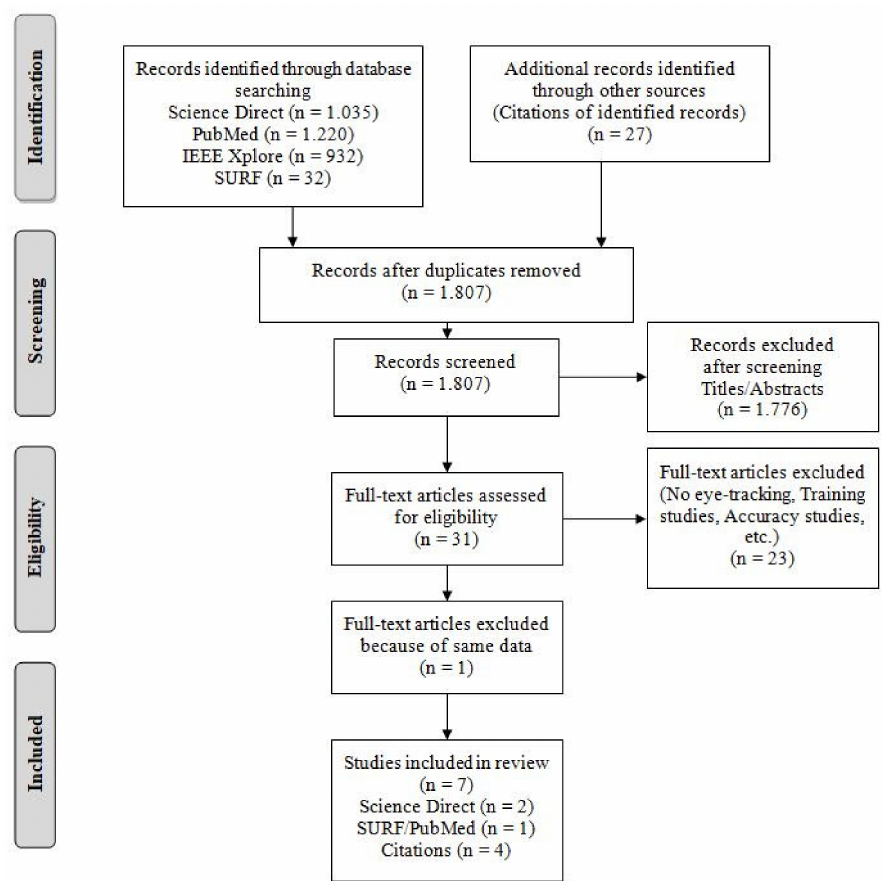
Figure 1. PRISMA flow diagram of literature